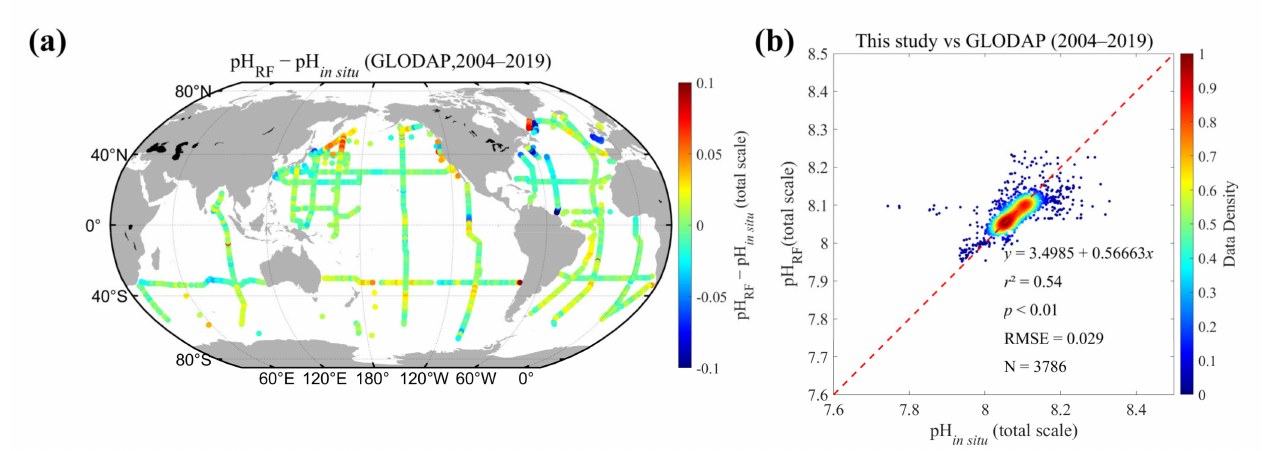
Figure 14. Global sea surface pH remote sensing product validation. ( a ) Sampling points after matching with the GLODAP in situ dataset, spanning the period 2004 to 2019. ( b ) Comparison between the in situ points and the estimated results on a 1:1 line, where R 2 = 0.54, RMSE = 0.029, and n =